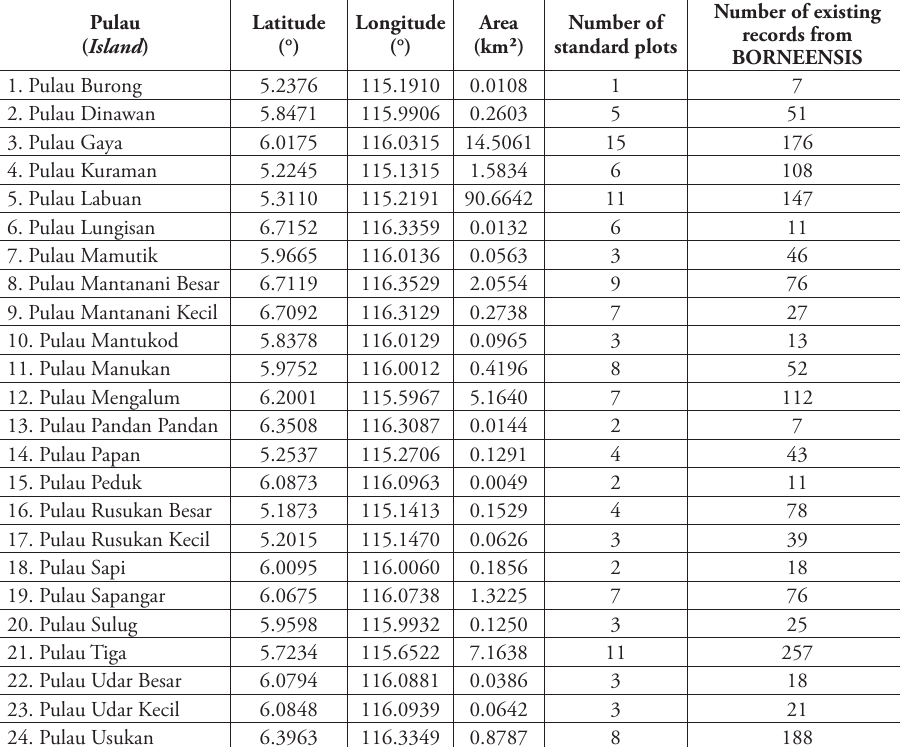
Table 1. Coordinates, areas (km²), numbers of standard plots, and numbers of existing records from BORNEENSIS for the 24 sampled